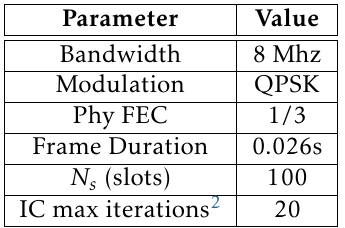
Table 4. Simulation parameters for the case